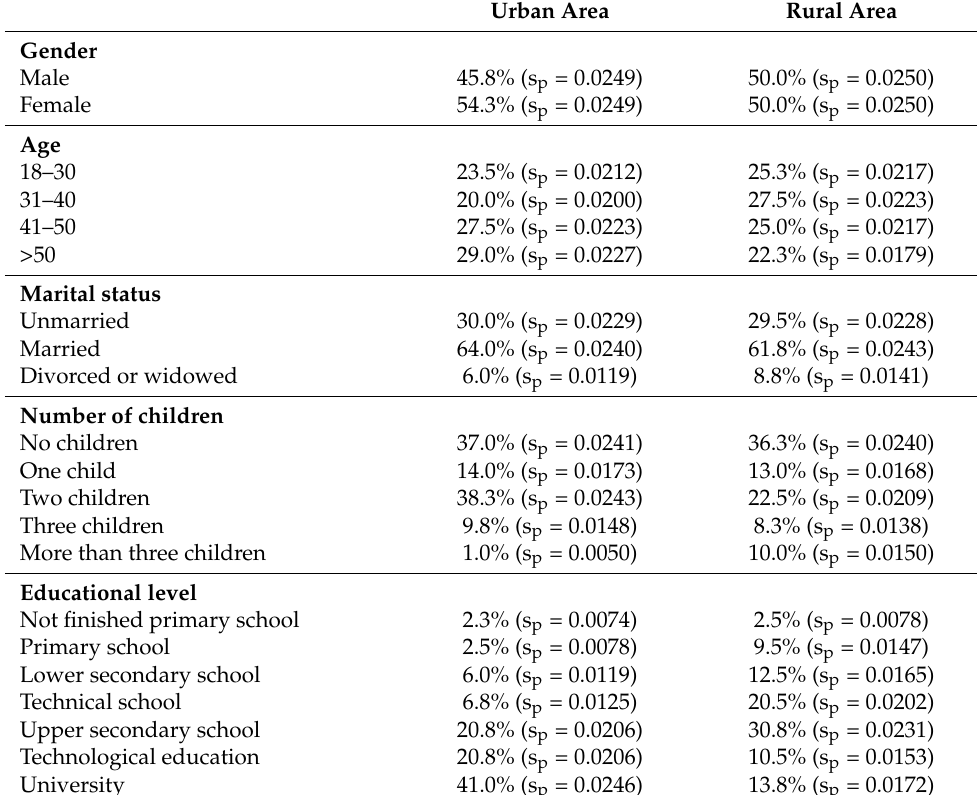
Table 1. Demographic characteristics of the citizens in both the urban and the rural area. Urban Area Rural